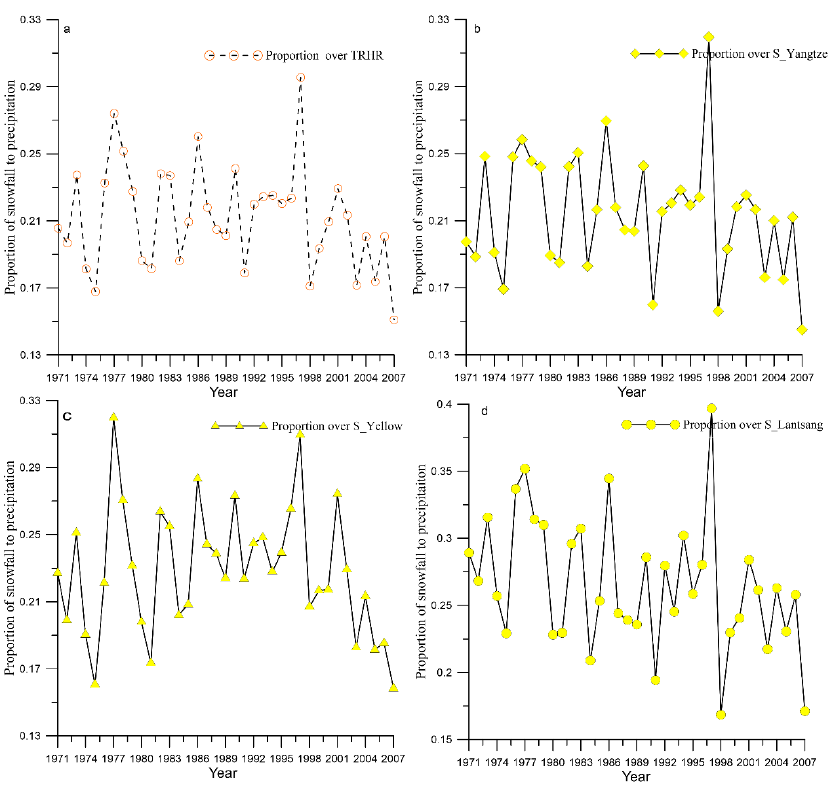
Figure 5. Annual variation of the ratio of snowfall to precipitation from 1971 to 2007 ( a ) over TRHR ( b ) S_Yangtze; ( c ) S_Yellow; ( d ) S_Lantsang.